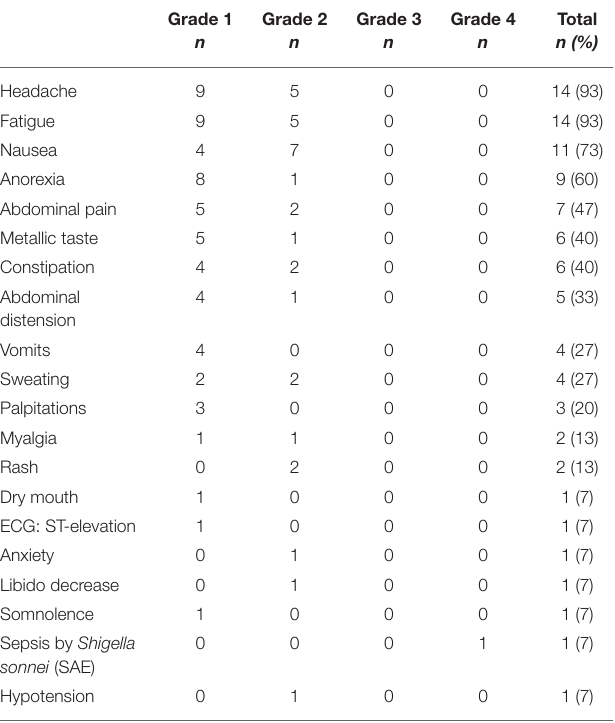
TABLE 3 | Summary of adverse events related to RMD 1 − 2 − 3 treatment ( n =